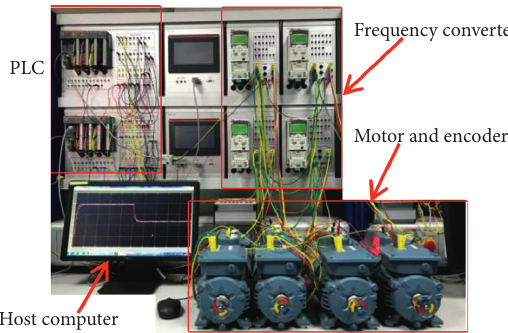
Figure 12: Semiphysical experiment platform.